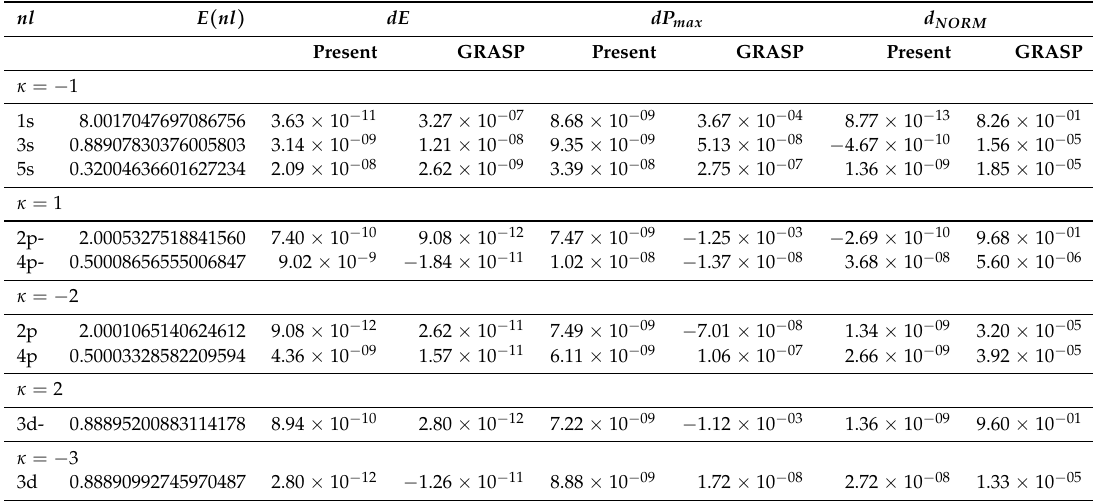
Table 8. Comparison of present methods with the mid-point methods used by